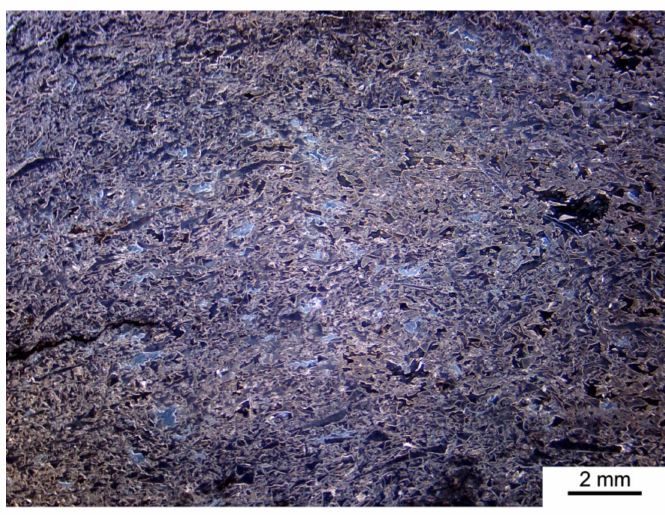
Figure 11. A representative area of the sample (10 ×